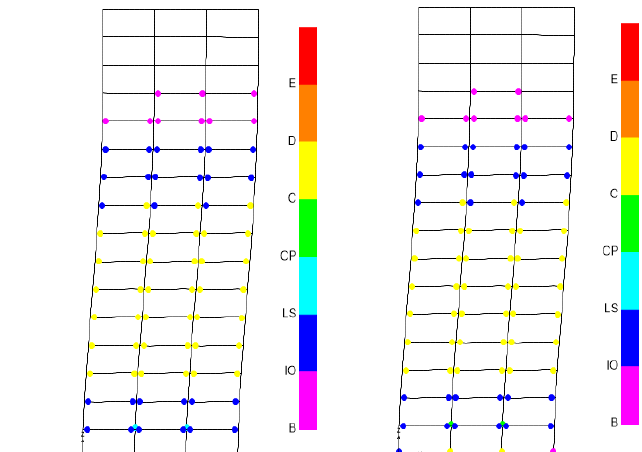
Figure 5. Nonlinear static pushover curves.